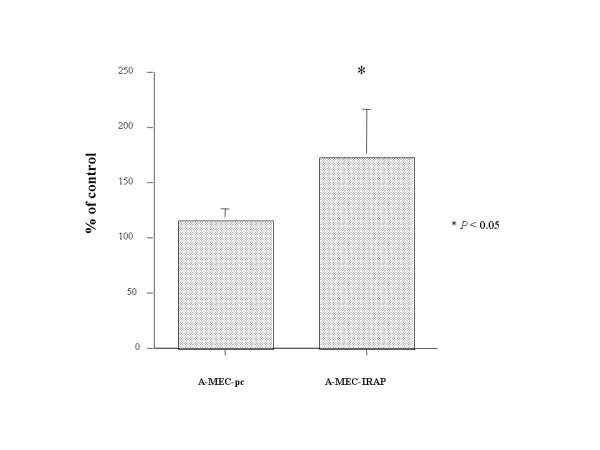
Cellular glucose uptake rates in A-MEC-pc and A-MEC-LAP cells. 3H-2-deoxyglucose uptake was measured as either basal or insulin-stimulated (10 nM insulin) for 30 min. Insulin-stimulated compared with basal rates in A-MEC-pc and A-MEC-LAP cells are shown. Data are expressed as the mean ± SEM of three separate experiments.